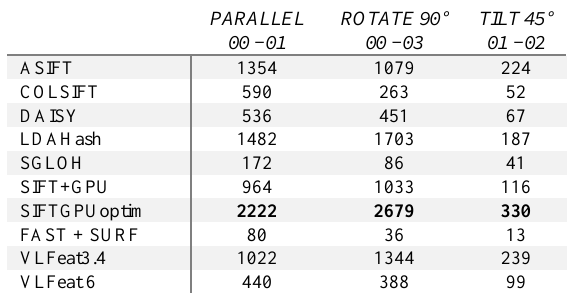
Table 2: Total number of correct inliers for each operator.